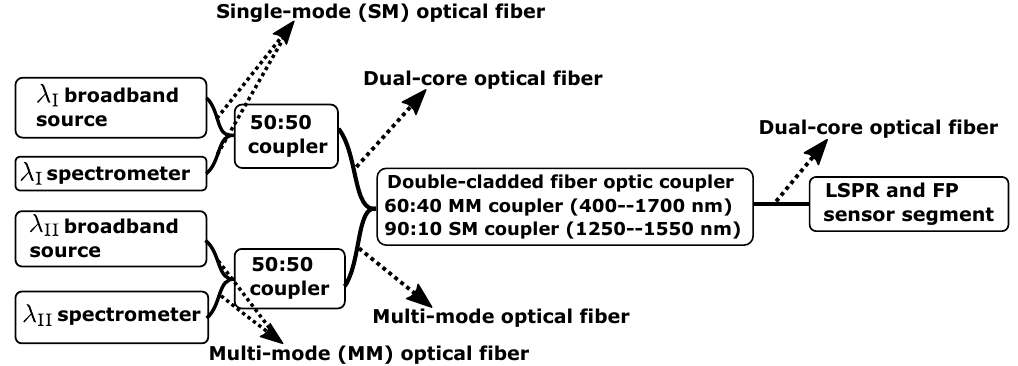
Figure 3. Setup of the fiber-optic instrument based on reflection